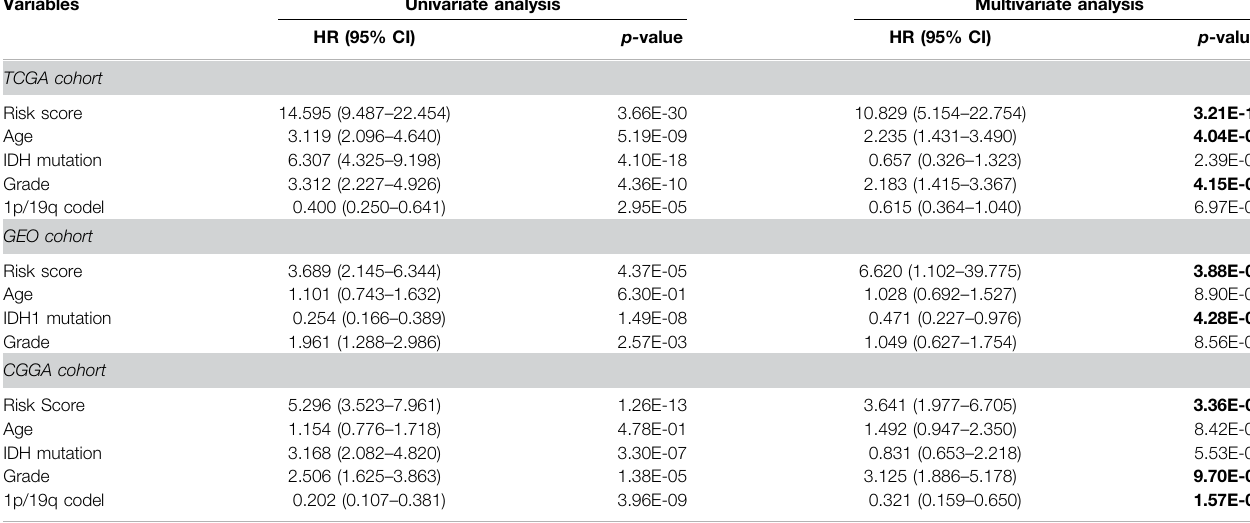
TABLE 1 | Univariate and multivariate Cox regression analysis of risk score and other clinical features in the TCGA/CGGA/GEO cohorts.